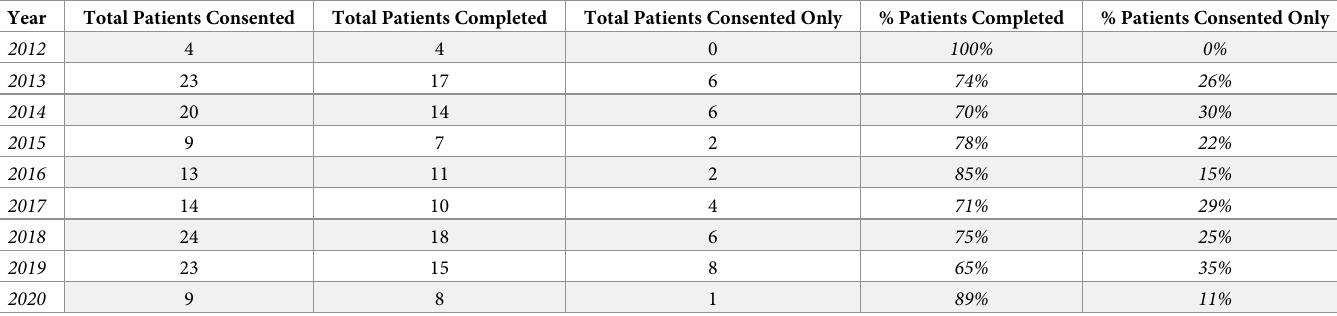
Table 1. Yearly patients consented for DBS research surgeries. Year Total Patients